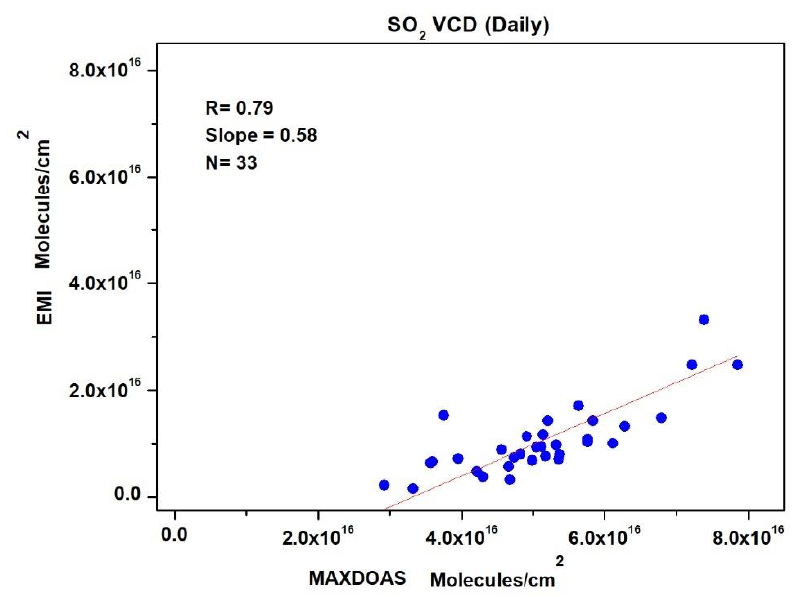
Figure 12. Scatter plot between MAX-DOAS and EMI SO 2 VCDs.